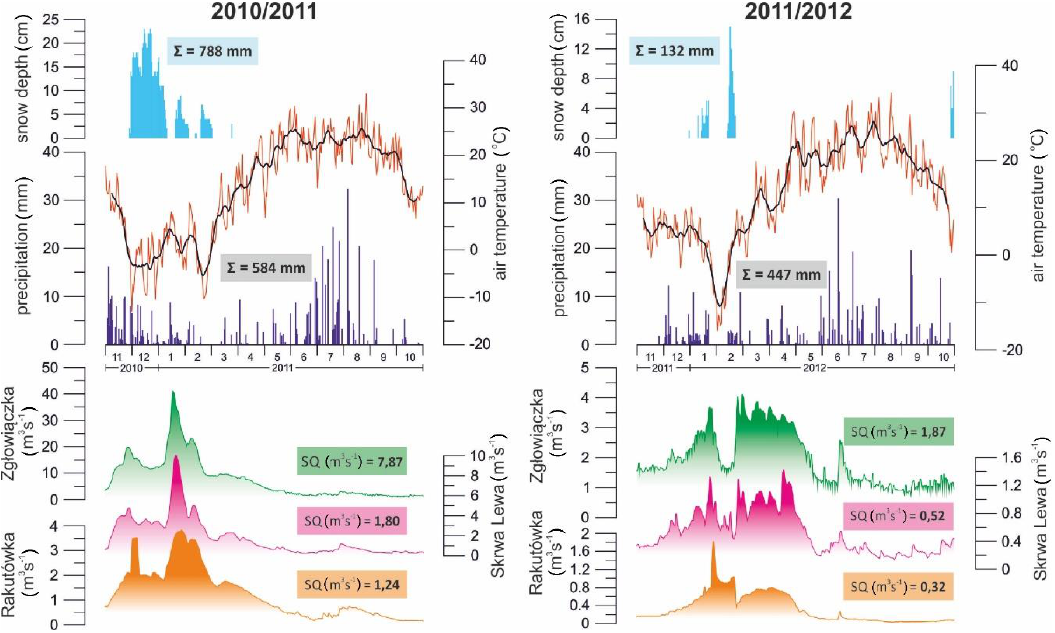
Figure 7. Hydrometeorological conditions in the study area in the water years of 2011 and 2012. High autumn precipitation greatly improved water supply in the studied catchments. At the end of November, the average daily air temperature dropped below zero, and there was heavy snowfall (Figure 7). The thickness of the snow cover reached 23 cm (22.XII.), while its average and total thickness in the period from November 28 to January 10 was 14.6 cm and 644 cm, respectively (in 2011 as a whole, 10.2 cm and 785 cm,